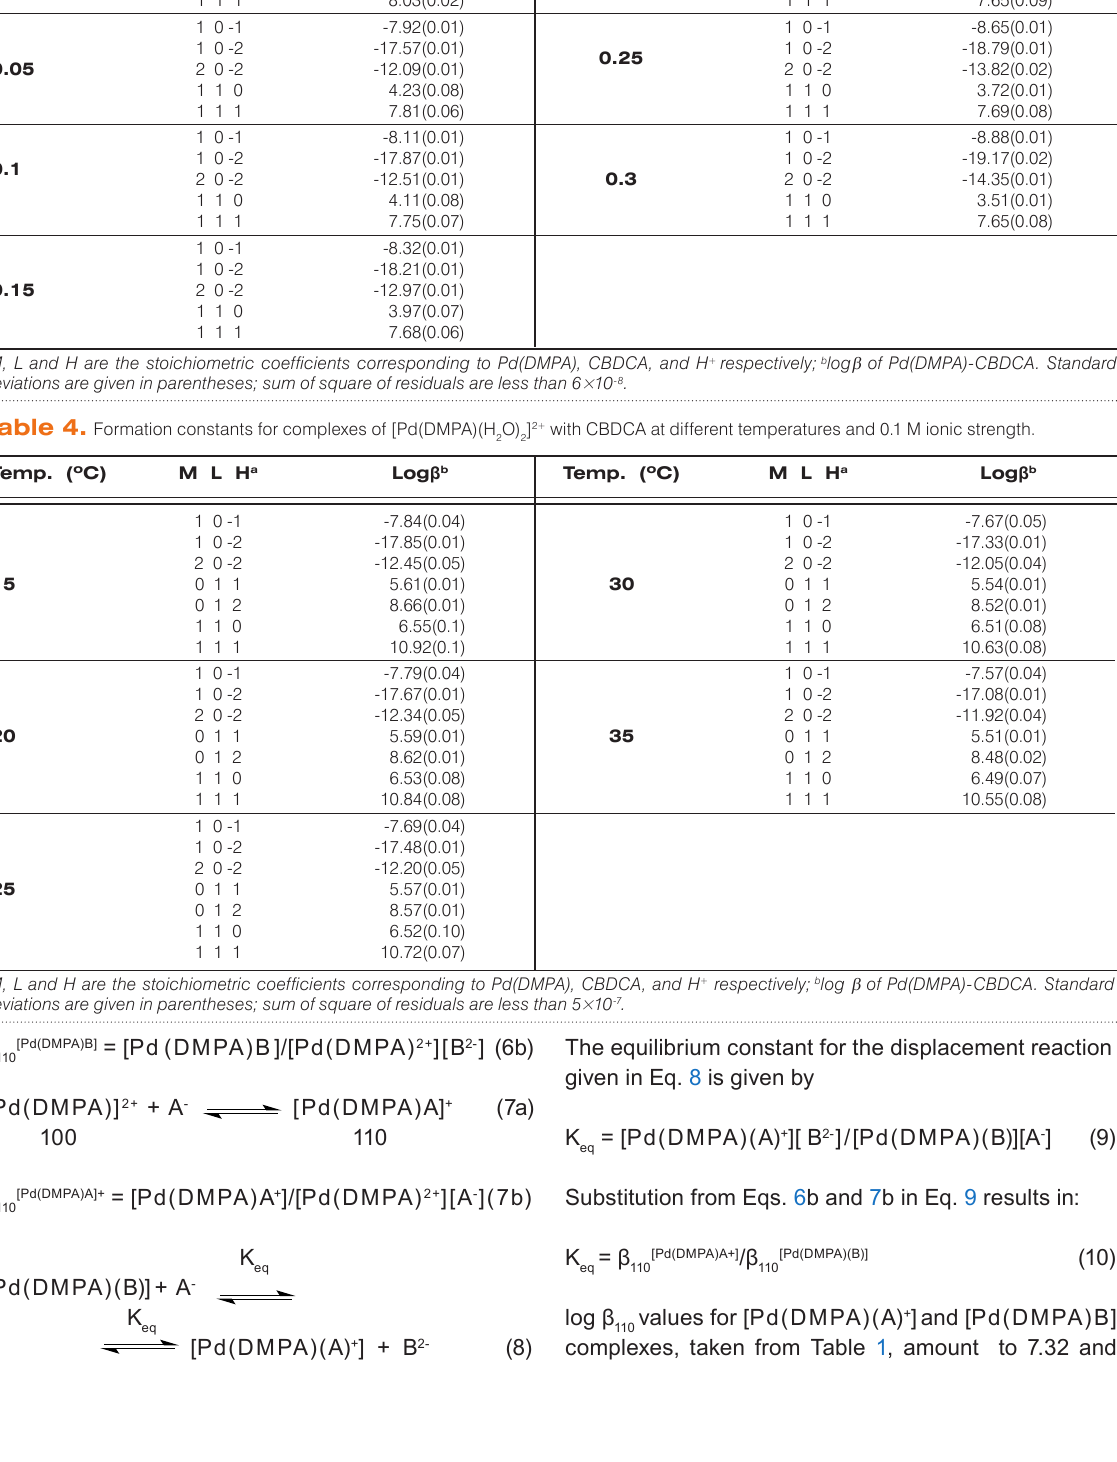
Table 3. Formation constants for complexes of [Pd(DMPA)(H 0.30 M ionic strength. [Cl - ] mol L -1